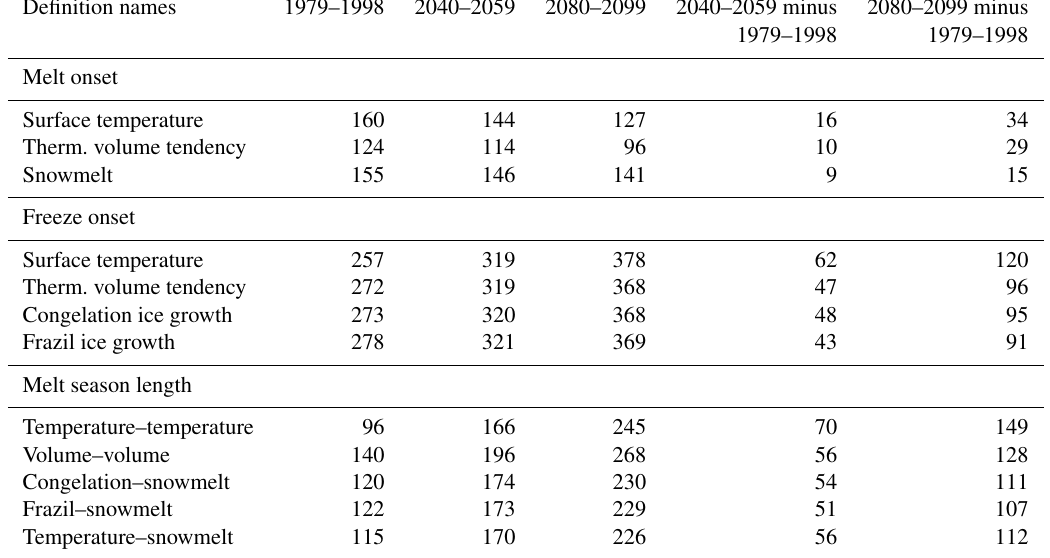
Table 4. Pan-Arctic ensemble means of melt season characteristics averaged over the time periods 1979–1998, 2040–2059 (mid-century) and 2080–2099 (end of century). Surface temperature and thermodynamic ice volume tendency definitions are averaged over 40 ensembles, and all other definitions are averaged over the two ensemble members for which they are available (members 34 and